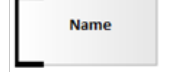
Fig. 1. Abstract graphic representation of a resource.